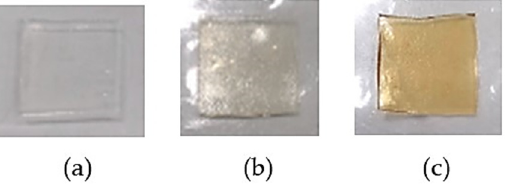
Figure 3. The hydrogel patches: ( a ) Gan/XG, ( b ) honey-loaded Gan/XG, and ( c ) D. bulbifera extract/honey-loaded Gan/XG.